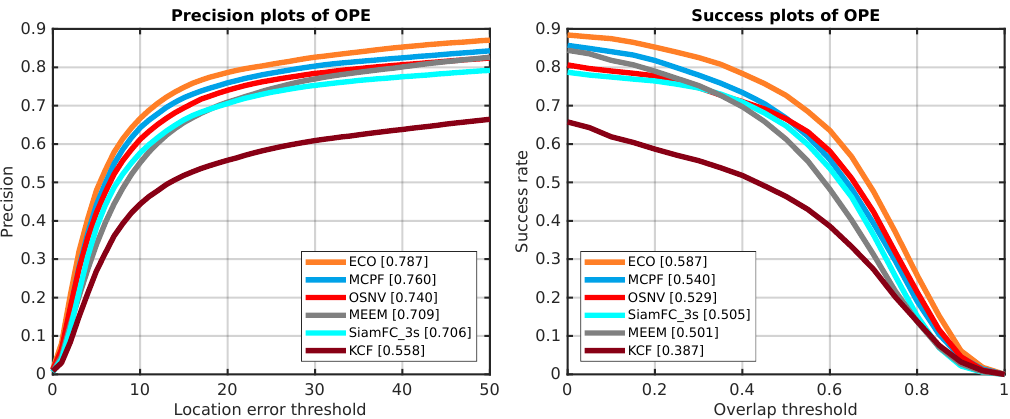
Figure 9. The OPE results of six tracking algorithms on TempleColor. The left side is precision plots and the right side is success plots, which are both evaluated on